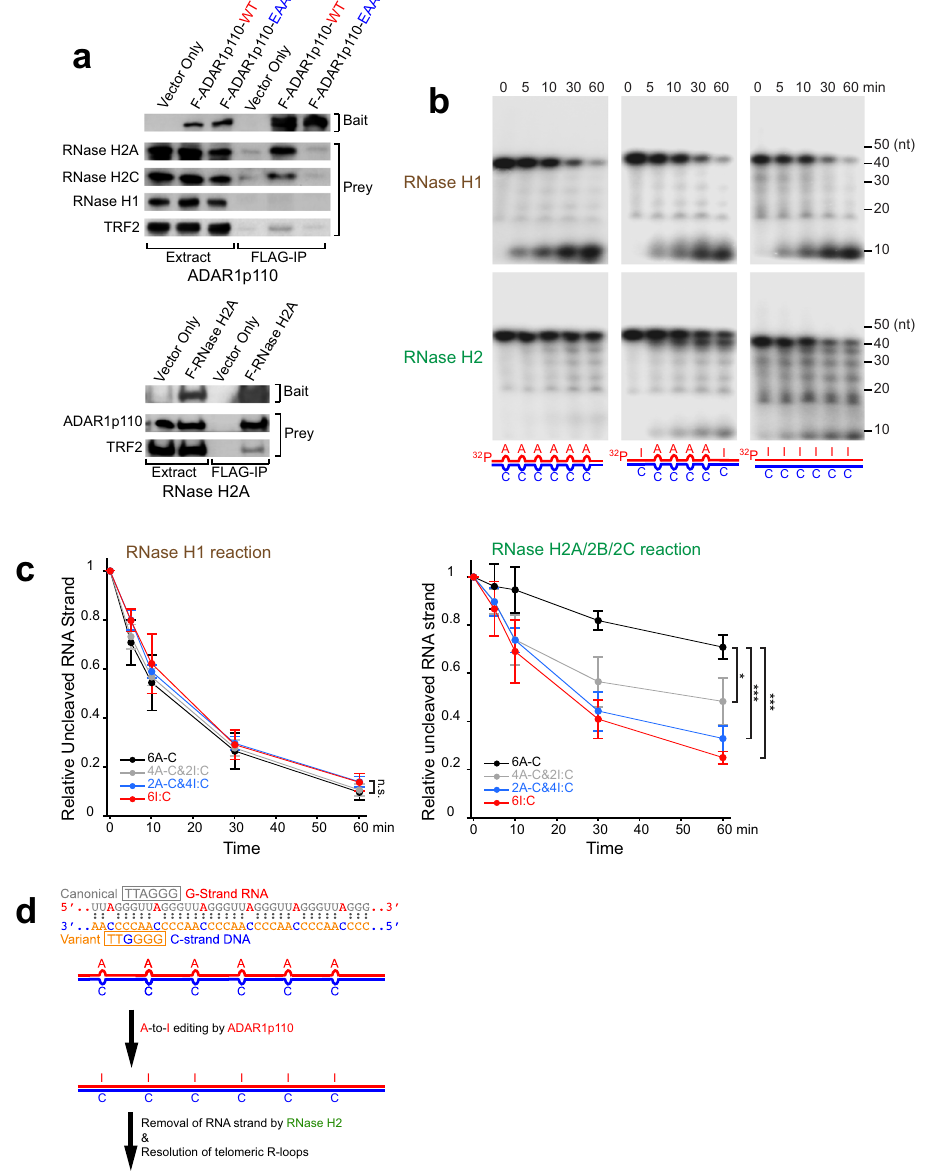
Fig. 8 Editing of A – C mismatches in telomeric repeat RNA:DNA hybrids facilitates RNase H2 cleavage of RNA strands. a F-ADAR1p110-WT recombinant protein was copuri fi ed with endogenous RNase H2 subunits H2A and H2C, but not with RNase H1. No RNase H2 association detected with a dsRNA-binding defective mutant F-ADAR1p110-EAA (upper panels). Similarly, FLAG-RNase H2A pulled down endogenous ADAR1p110 (lower panels). Note that both FLAG-AFAR1p110 and FLAG-RNase H2A pulled down endogenous TRF2, a telomere-binding protein and a member of the Shelterin complex, supporting our hypothesis that ADAR1 and RNase H2 collaborate together to resolve telomeric R-loops. Protein molecular weight markers are presented in Source Data fi le. b In vitro assay for digestion of 5 ′ - 32 P-labeled RNA strands of telomeric repeat RNA:DNA hybrids by RNase H1 or RNase H2A/2B/2C complexes. RNase H2 could not degrade the RNA strands of telomeric repeat RNA:DNA hybrids containing six A – C mismatches, but began digesting RNA strands of RNA:DNA hybrids containing four A – C mismatches. Replacement of all A – C mismatches with I:C-matched base pairs resulted in ef fi cient digestion of RNA strands by RNase H2. RNase H1 degraded RNA strands regardless of the number of A – C mismatches. c Time course of digestion of RNA strands of telomeric repeat RNA:DNA hybrids with varying numbers of A – C mismatches by RNase H1 or RNase H2. Data are mean ± SD ( n = 4, technical replicates); signi fi cant differences were identi fi ed by two-tailed Student ’ s t tests: * P < 0.05, *** P < 0.001, n.s., not signi fi cant. All individual experimental data values and exact P values are presented in Supplementary Data 3. d A-to-I editing of A – C mismatches to I:C base pairs in RNA:DNA hybrids facilitates digestion of RNA strands by RNase H2.